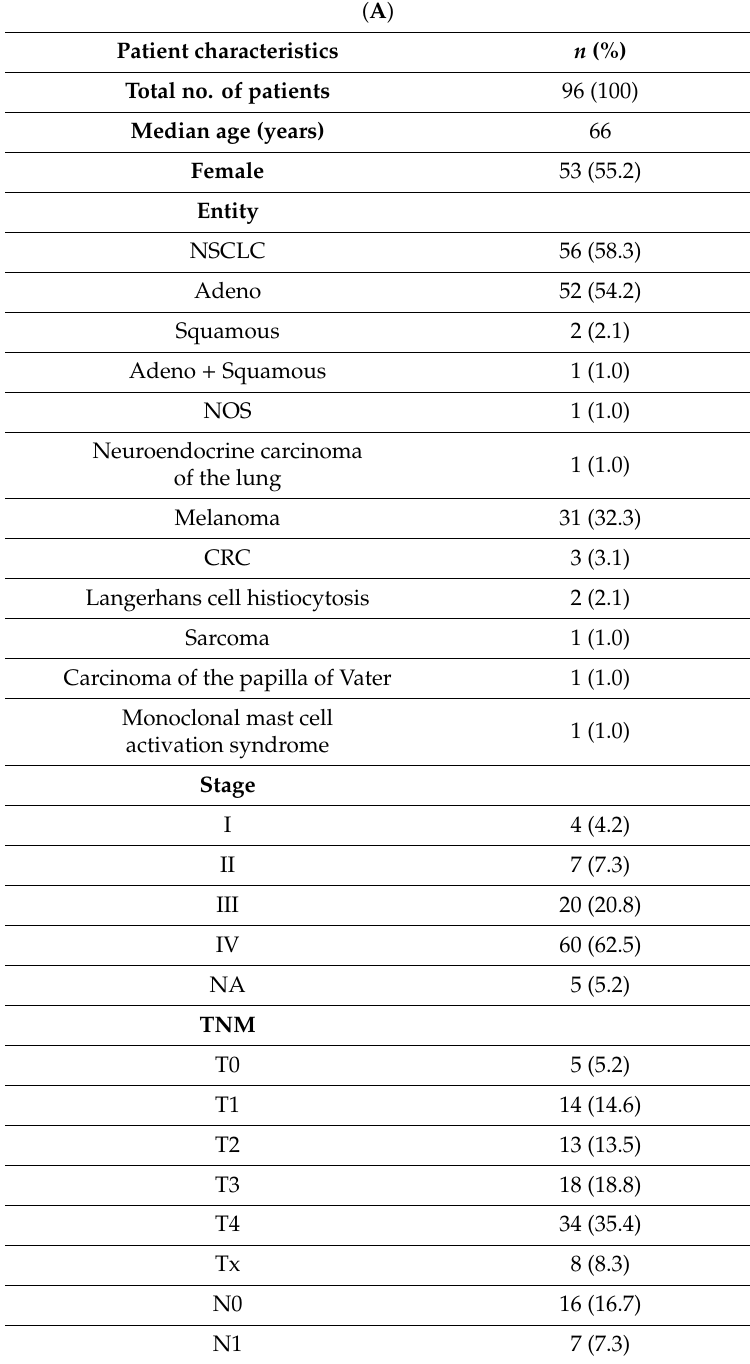
Table 1. Patient and sample overview. ( A